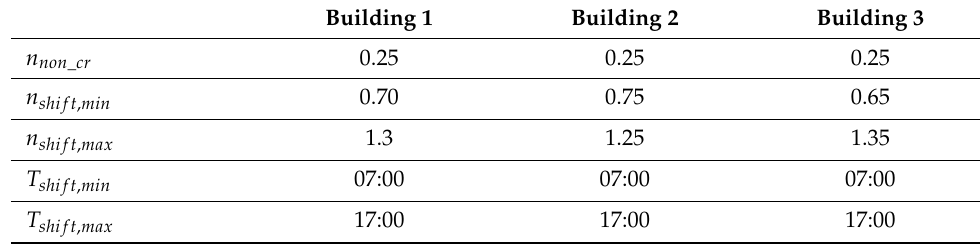
Table 4. Non-critical loads’ parameters.